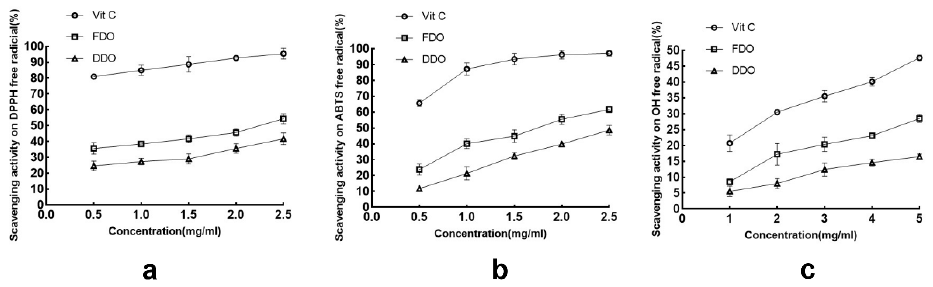
Figure 1. The scavenging effects of the FDO (fresh Dendrobium officinale ) and DDO (dried Dendrobium officinale ) on DPPH ( a ), ABTS ( b ), and hydroxyl free radicals ( c ).